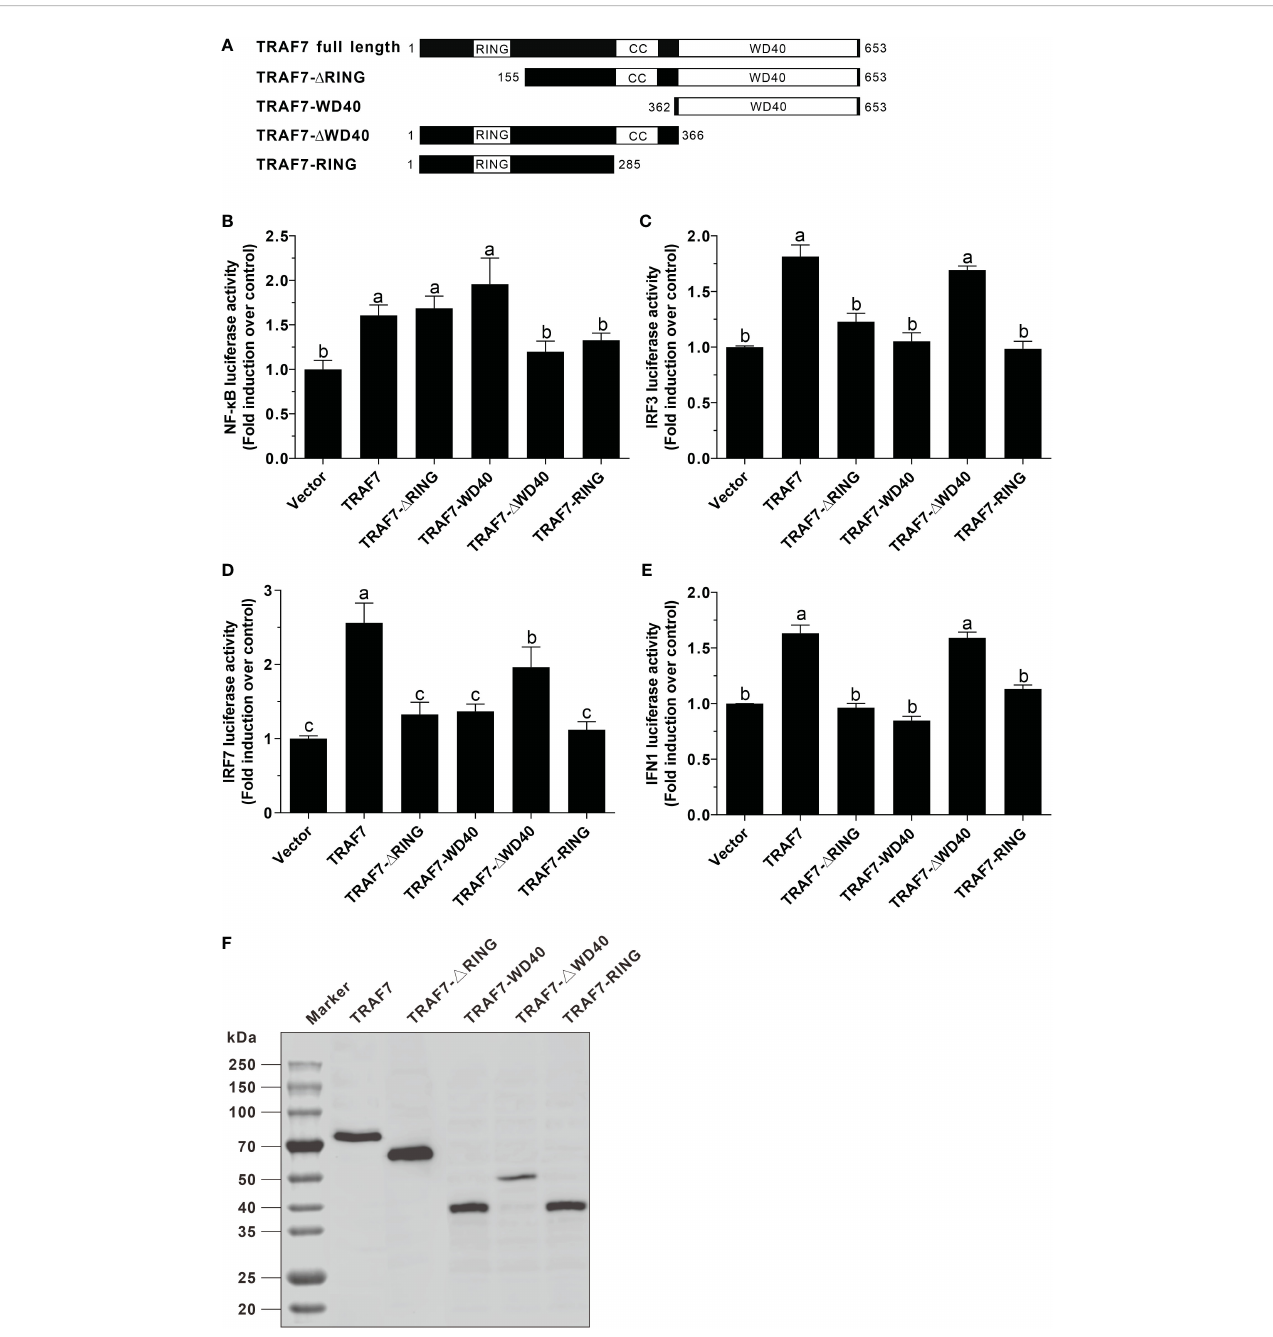
FIGURE 6 Function of Lc -TRAF7 and its domains in NF- k B, IRF3, IRF7, and IFN1 promoter activation. (A) Schematic representation of large yellow croaker TRAF7 full length and the truncated forms used in this study. Induction of NF- k B (B) , IRF3 (C) , IRF7 (D) , and IFN1 (E) promoter activity by Lc -TRAF7 and its truncated forms. HEK 293T cells seeded in 24-well plates were co-transfected with 100 ng of pNF- k B-luc, pGL4-IRF3-pro, pGL4-IRF7-pro, or pGL4-IFN1-pro, 10 ng of pRL-TK together with 100 ng of the constructed plasmids including pcDNA3.1-TRAF7, pcDNA3.1-TRAF7- D RING, pcDNA3.1-TRAF7-WD40, pcDNA3.1-TRAF7- D WD40, or pcDNA3.1-TRAF7-RING. At 24 hpt, the cells were collected for detecting luciferase activity, with the results normalized to the Renilla luciferase activities and presented as the fold induction relative to the control group transfected with the pcDNA3.1 empty vector. (F) Lysates of the cells transfected with pcDNA3.1-TRAF7, pcDNA3.1-TRAF7- D RING, pcDNA3.1-TRAF7-WD40, pcDNA3.1-TRAF7- D WD40, or pcDNA3.1-TRAF7-RING plasmids were analyzed for the expression of the full-length Lc -TRAF7 or its truncated forms by Western blotting analysis using a mouse monoclonal Anti-c-Myc antibody. All data were shown as mean of three independent experiments, with bars representing the SE. Different letters above the bars indicate statistically signi fi cant differences between the groups ( P <